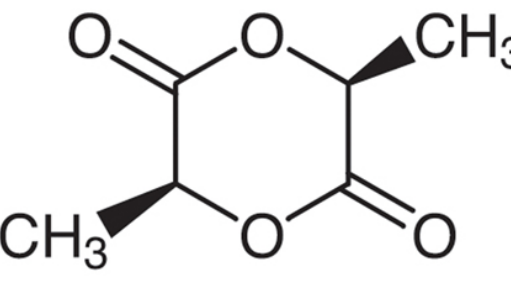
Figure 2. Structural formula of L ‐